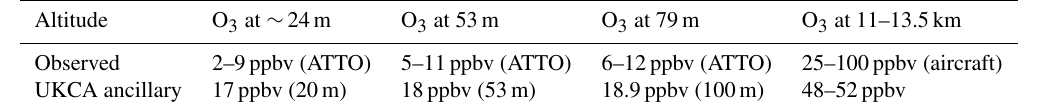
Table A2. Ozone concentrations from the observations and the domain-averaged ozone concentrations from the monthly averaged ancillary of UKCA.